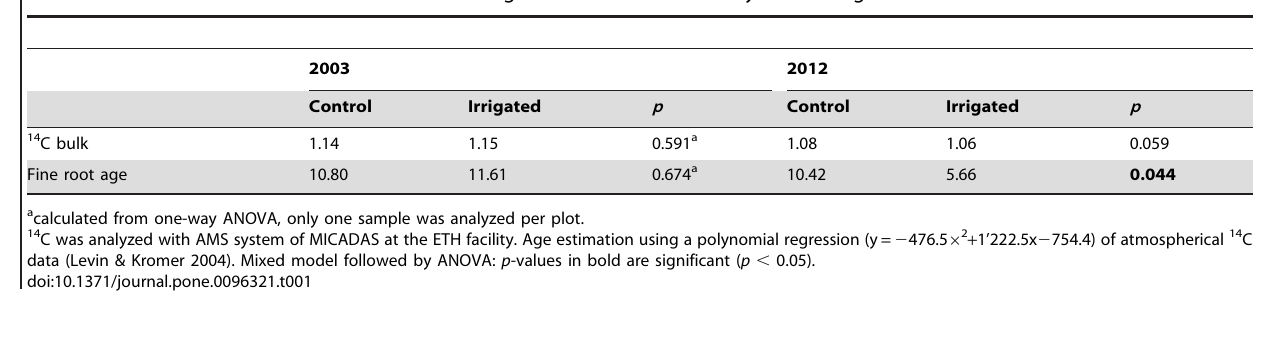
Table 1. Measured 14 C and estimated fine root age before and after nine years of